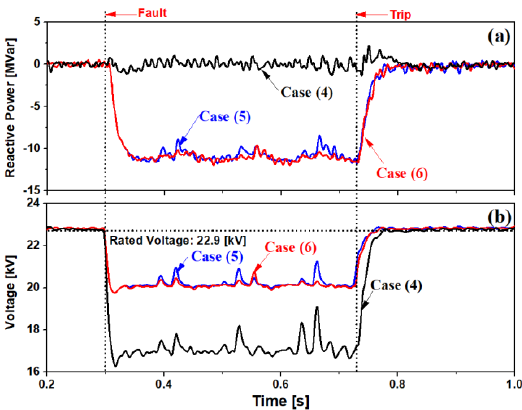
Figure 14. Simulation Results in Case (4)-(6): ( a ) Reactive Power of VSC (Voltage-Sourced Converter); ( b ) AC Power System RMS (Root Mean Square) Voltage. ( b ) AC Power System RMS (Root Mean Square) Voltage.